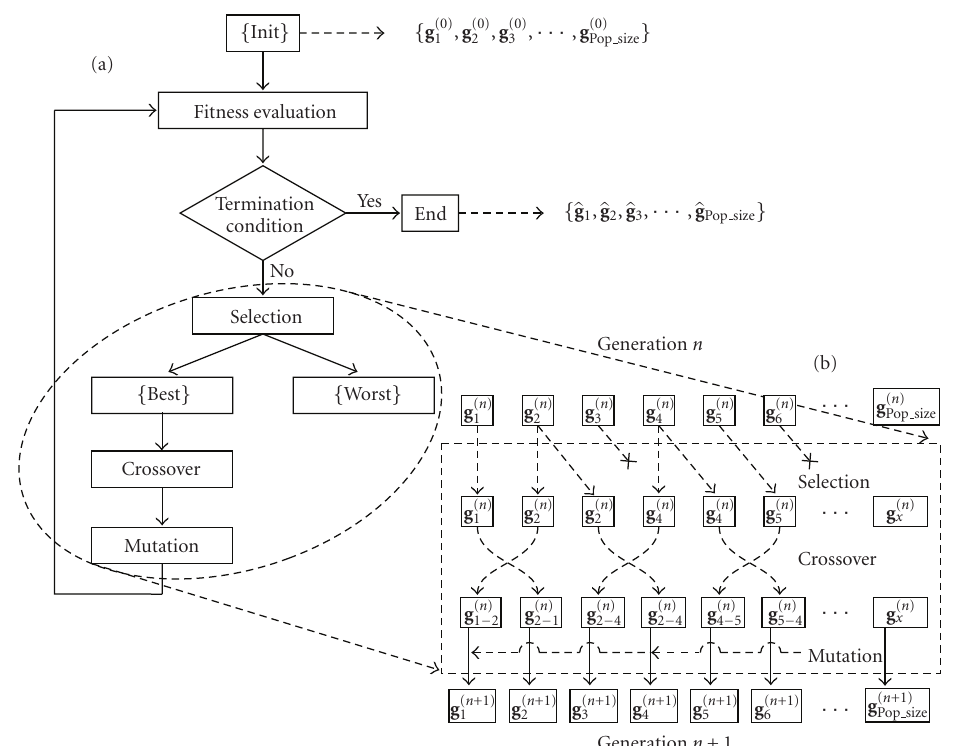
Figure 4: Flowchart of the proposed GA (a) and the three steps for the creation of a generation (b).